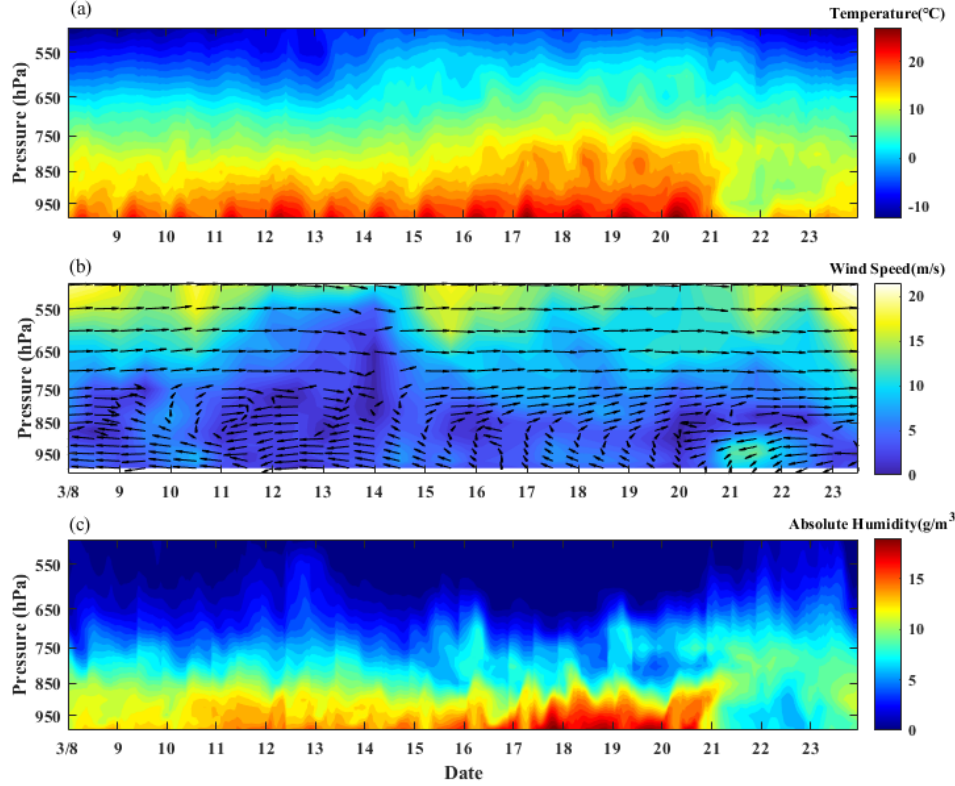
Figure 12. Variations in meteorological elements at different pressure levels from 8 to 23 March 2021. ( a ) Temperature ( °C ), ( b ) wind direction and wind speed (m/s), and ( c ) absolute humidity (g/m 3 ).